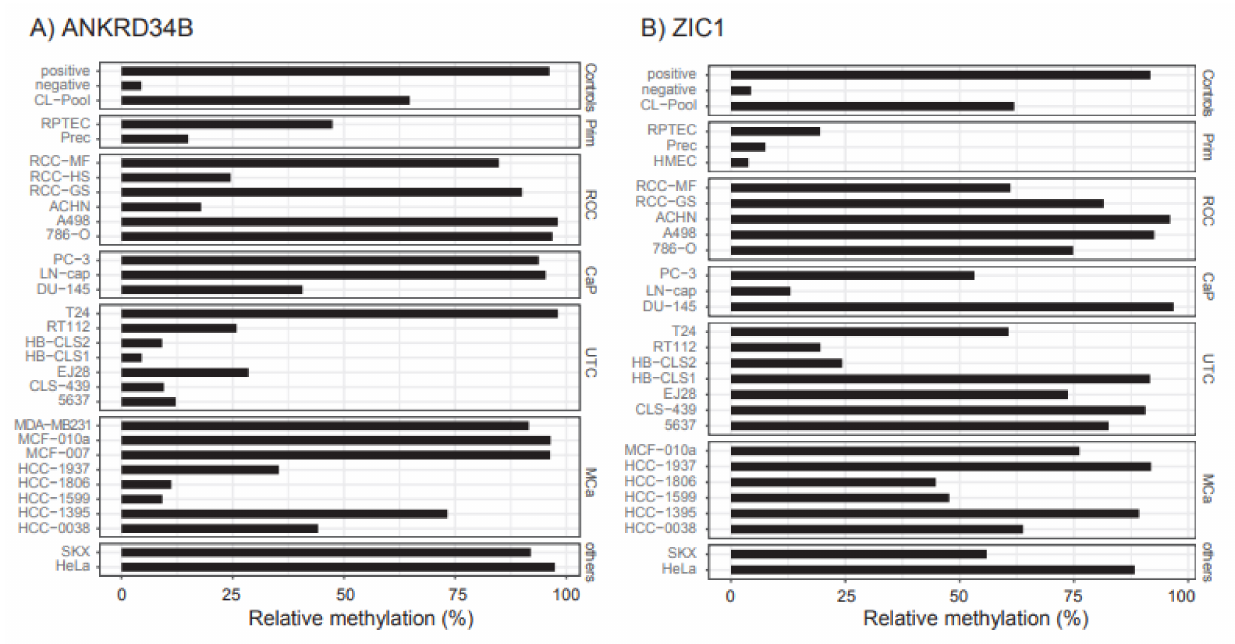
Figure 6. ( A ) ANKRD34B ; ( B ) ZIC1 . Analysis of candidate region methylation in various human tumor cell line models and controls. Designated human tumor cells were grouped according to tumor origins (RCC, renal cell cancer, CaP, prostate cancer, UTC, urothelial tumor cells, MCa, breast cancer and